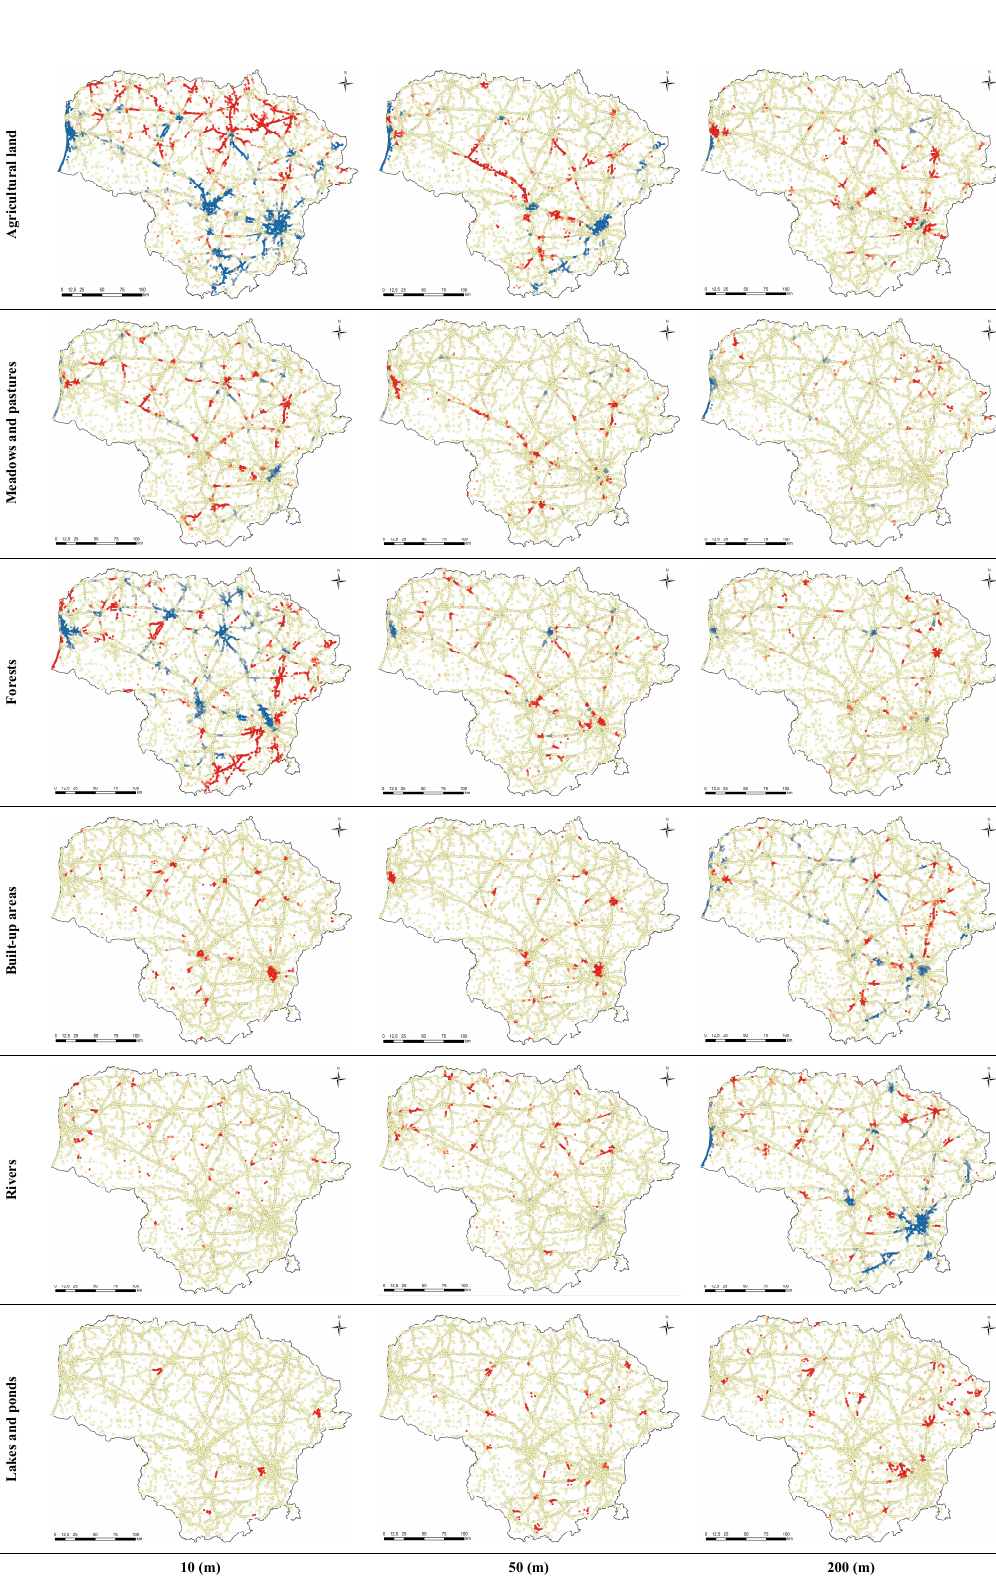
Figure 3. Distribution of hot spots (red) and cold spots (blue) of WVCs in Lithuania combining all land-use types and distances (large map) and by land-use type at three distance categories—10 m, 50 m, and 200 m (small